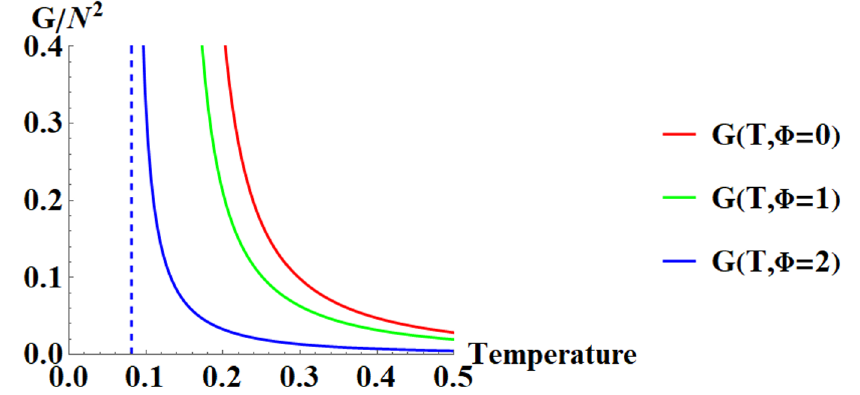
Figure 7 . Free energy as function of temperature when Ω a,b = 1 and Φ 6 = 3 . There are only “small” black holes . They all have G > 0 and negative specific heat ( G decreases with temperature). The curves represent Φ = 0 , 1 , 2 (from right to left). The vertical asymptote indicating the minimal temperature is shown only for Φ = 2 , to reduce clutter. As Φ increases to Φ → 3 − the minimal temperature decreases to T = 0 . The BPS limit where Φ = 3 exactly is not a curve, it is just min the origin where T = 0 and G = 0